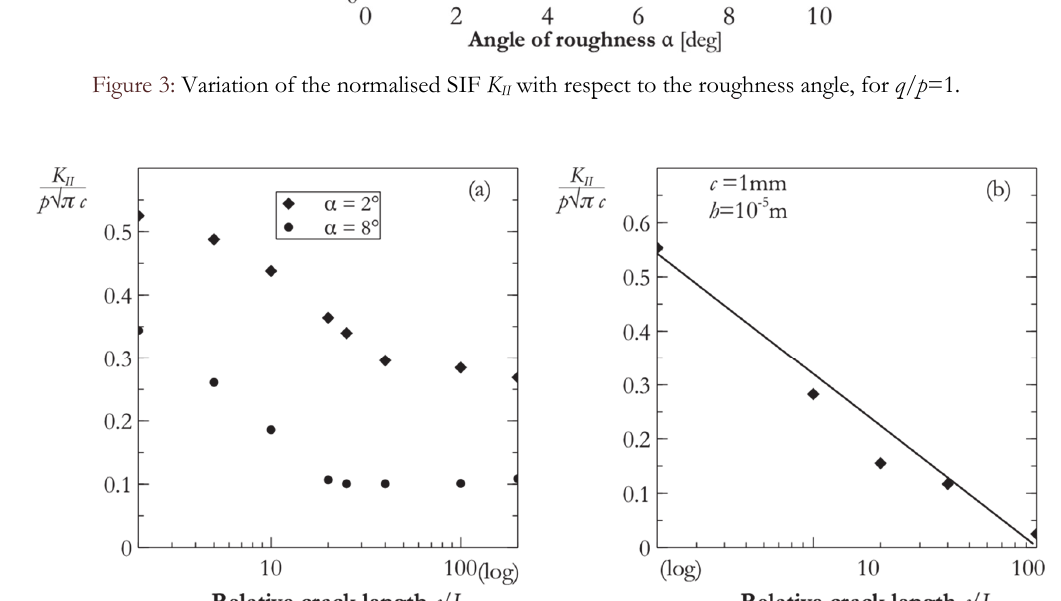
Figure 4: (a) Variation of the normalised SIF K II with respect to the relative crack length c/L , for q/p =1. The angle of the surface asperity is kept constant. (b) Variation of the normalised SIF K II with respect to the relative crack length c/L , for q/p =1. The height of the surface asperity is kept constant. The coefficient of friction is equal to 0.5 in all the